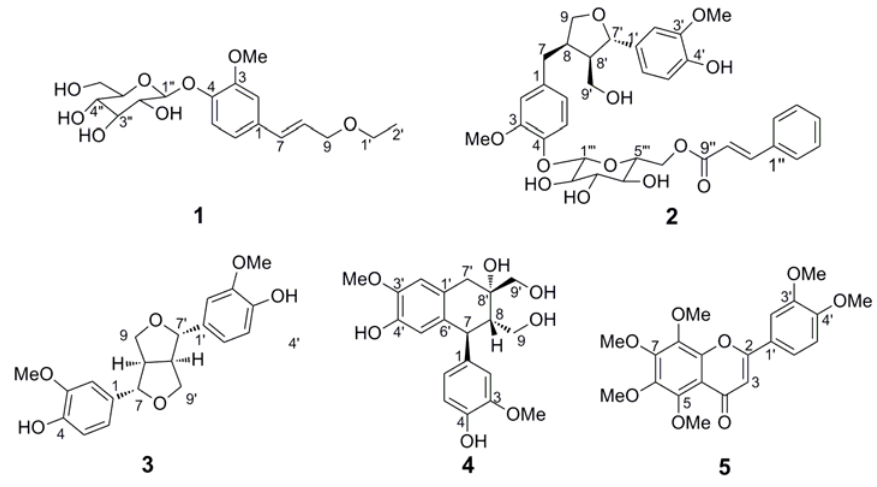
Figure 1. The structures of compounds 1 – 5